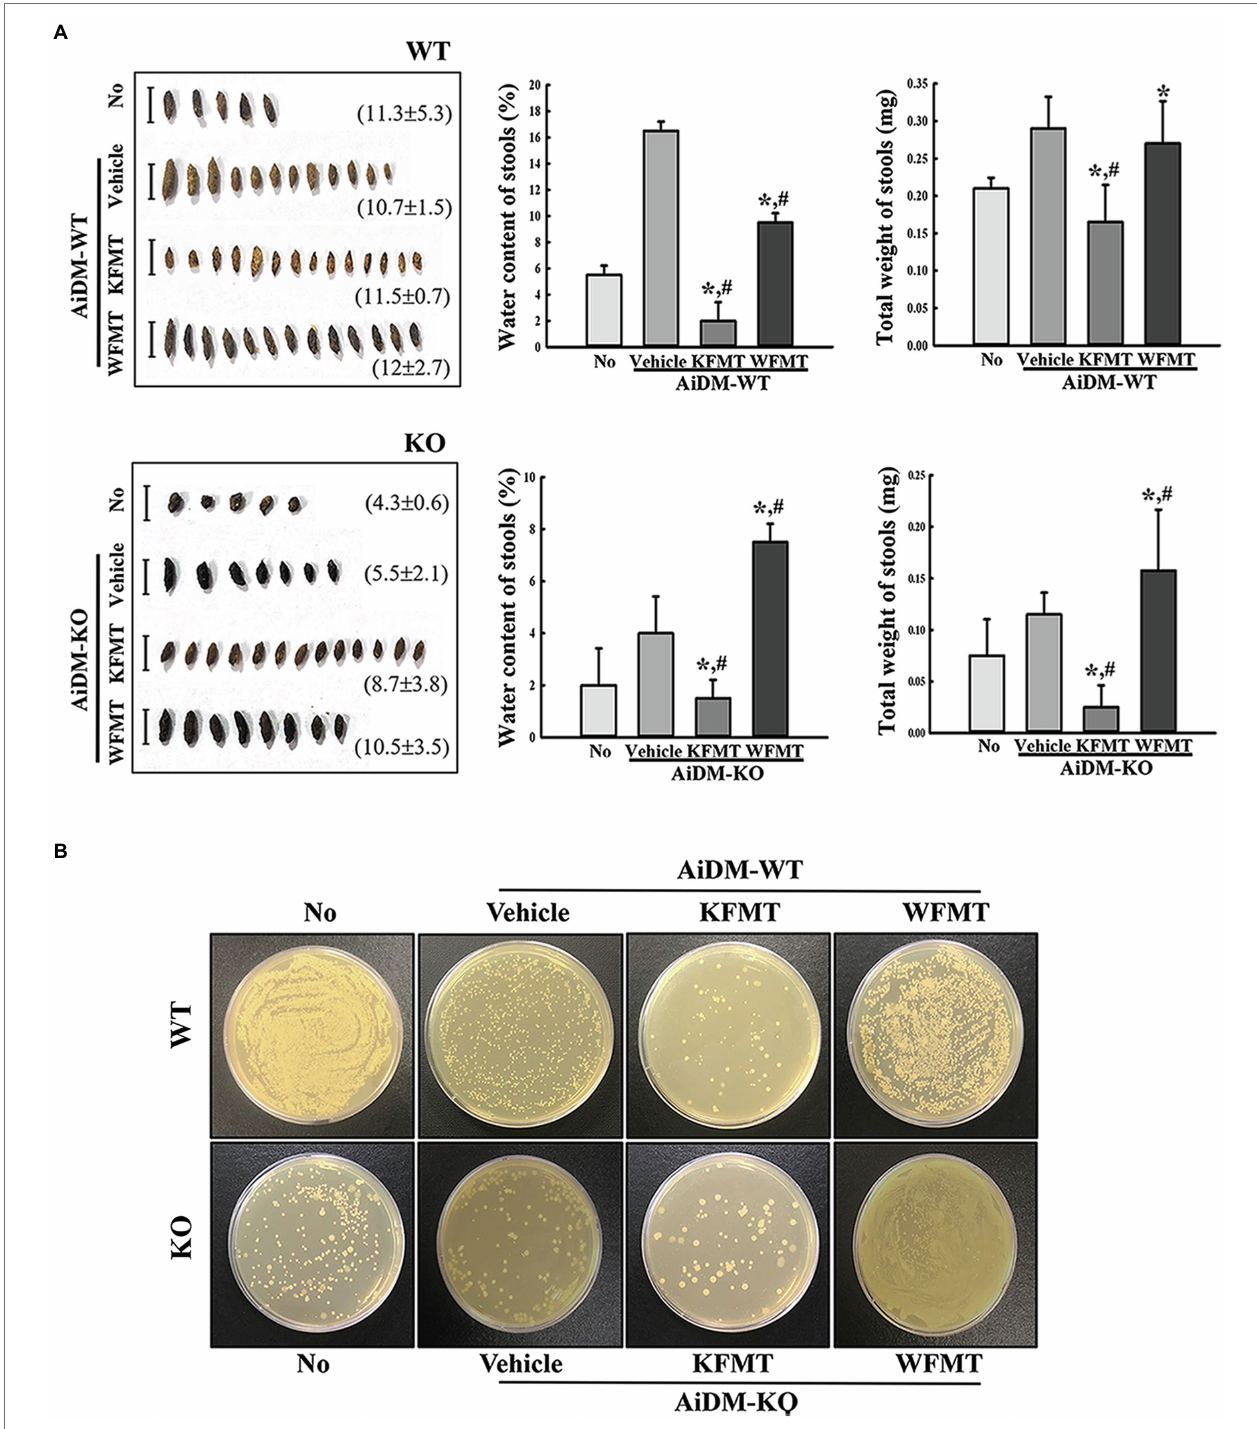
FIGURE 4 | Stool parameters and fecal microbiota in FMT mice. (A) Stool morphological characteristics. Digital camera images of stools were taken immediately after collection from a metabolic cage. The total number and weight of stools were measured as described in Materials and Methods. Stool water content was calculated by comparing the weight of fresh stool and dried stool weight. (B) Cultivation of fecal microbiota. Microorganism colonies formed on the nutrient agar were observed in a view box. Three to five mice per group were used for stool collection, and each parameter was assayed in duplicate. The data are reported as mean ± SD values. * p < 0.05 compared with the No-treated group. # p < 0.05 compared with the AiDM+Vehicle-treated group. WT, wild type; KO, knockout; FMT, fecal microbiota transplantation; KFMT, knockout mice FMT; WFMT, wild-type mice FMT; AiDM, antibiotics-induced depletion of microbiota; AiDM-WT, AiDM-wild- type mice; and AiDM-KO, AiDM-knockout